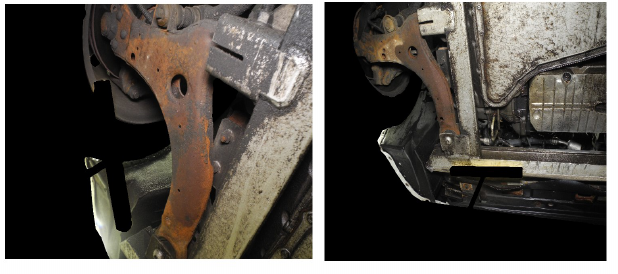
Figure 8. Sample images from dataset 2 consisting of masked images.